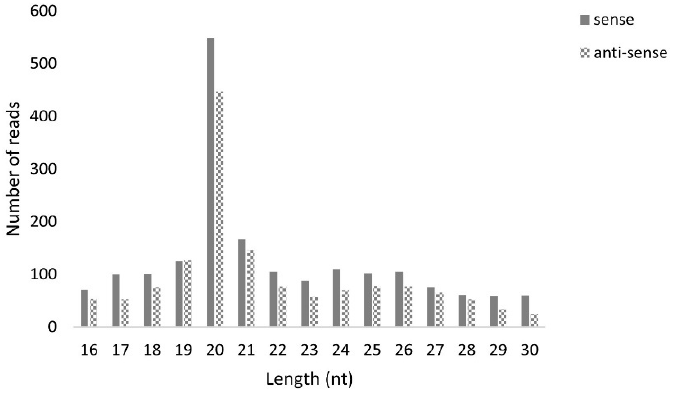
Figure 16. Length distribution of B. mori Macula-like Latent Virus (MLV) sRNAs in High Five cells. The Y -axis represents the number of reads mapped to MLV. The X -axis represents the length of the reads in nucleotides. Solid bars: sense reads. Dotted bars: anti-sense reads.